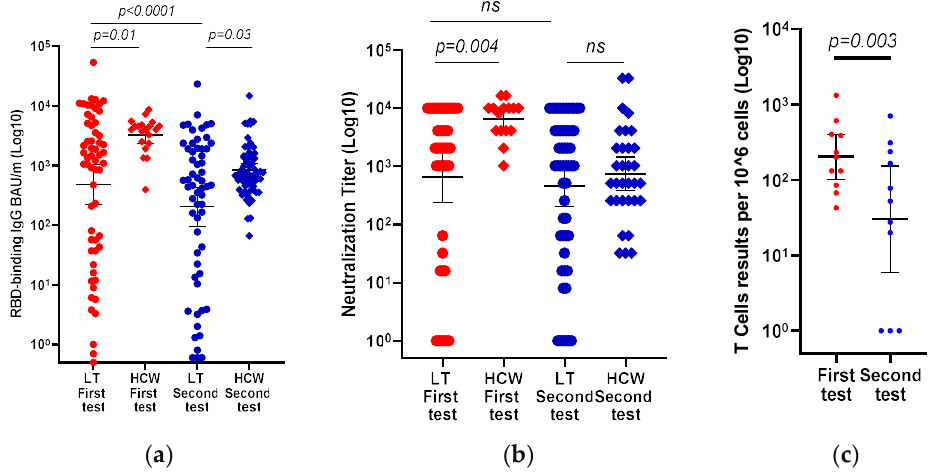
Figure 1. Comparison of immune responses of liver transplant recipients versus control immuno- competent subjects, after the third BNT162b2 vaccine dose was administered. Scatter plots showing the changes in anti-RBD IgG ( a ), neutralizing antibody ( b ) titers, and T-cell counts ( c ) at a median of 22 days (first test) and 133 days (second test) after administration of the third vaccine dose. The black horizontal line indicates the geometric mean values with a 95% confidence interval. Differences in paired samples were calculated using the Wilcoxon matched-pairs signed-rank